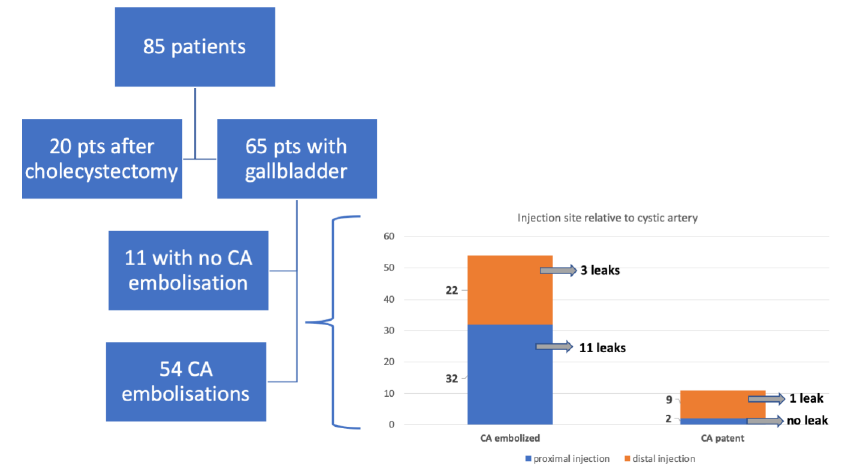
Figure 2. Flowchart presenting the sites of extrahepatic leaks.